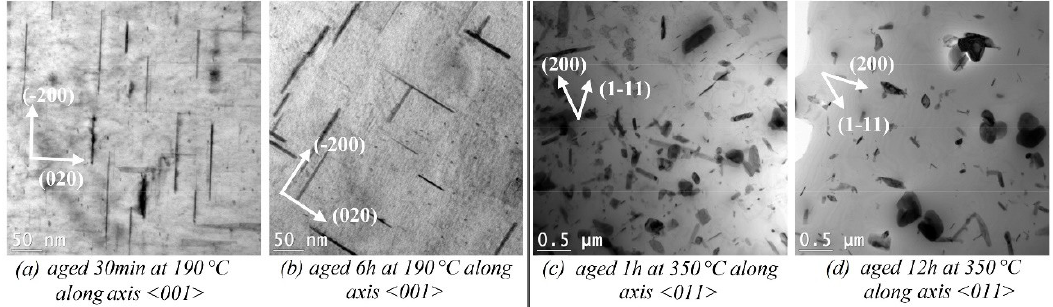
Figure 7. TEM observations for the AlSi7Cu3.5Mg0.15 (Mn, Zr, V) alloy in g200 beam condition.